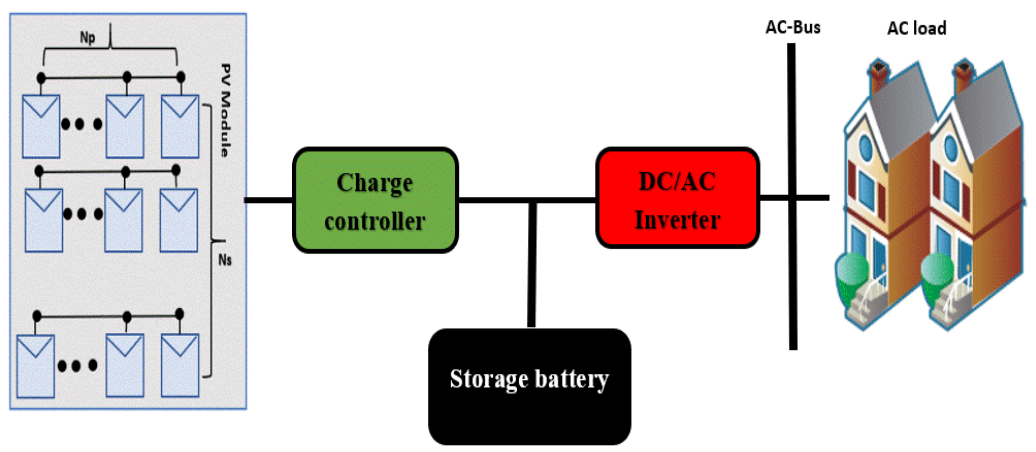
Figure 1. The block diagram of a generalized stand-alone photovoltaic (SAPV) system.